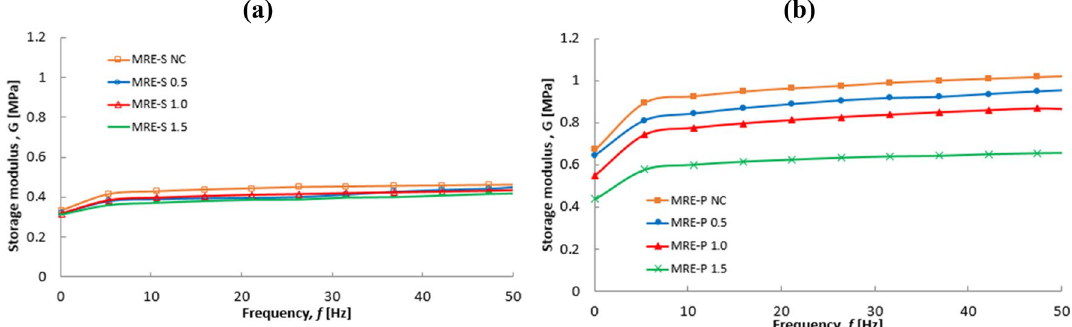
Figure 11. Storage modulus versus frequency of MREs containing different shapes, ( a ) spherical and ( b ) plate- like CIPs at 3A (on-state) condition.